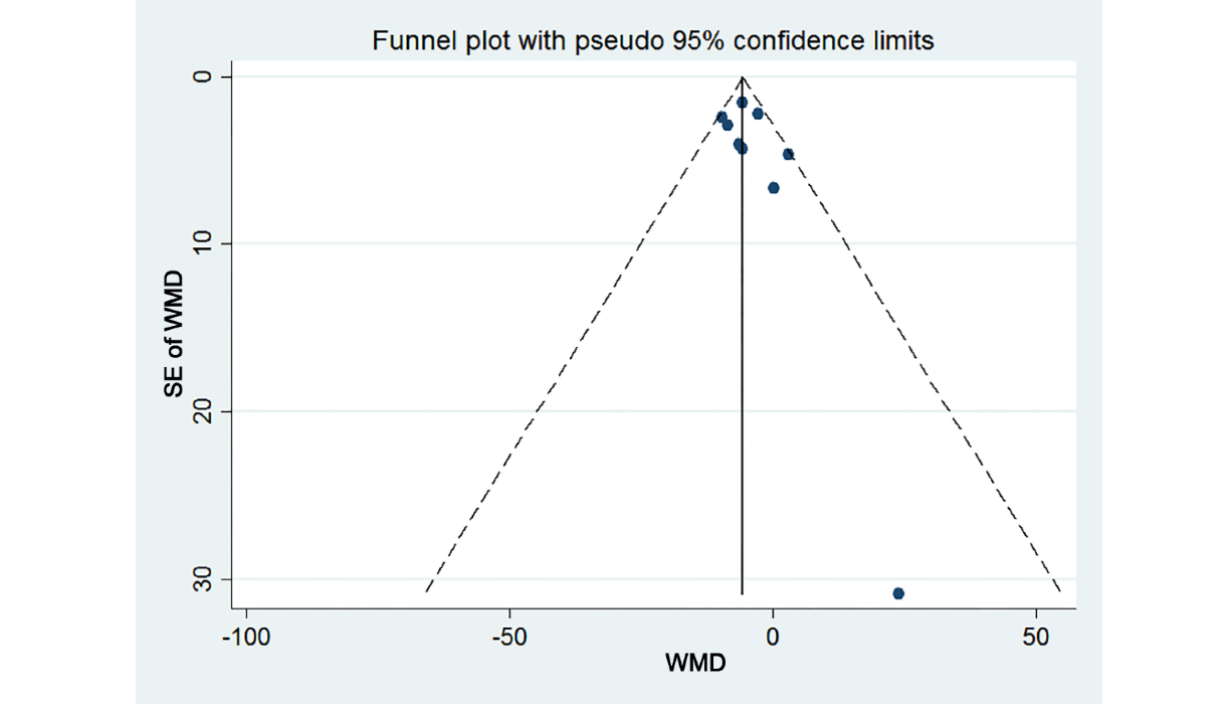
Figure 6. Funnel plot of the systolic blood pressures. WMD: weighted mean